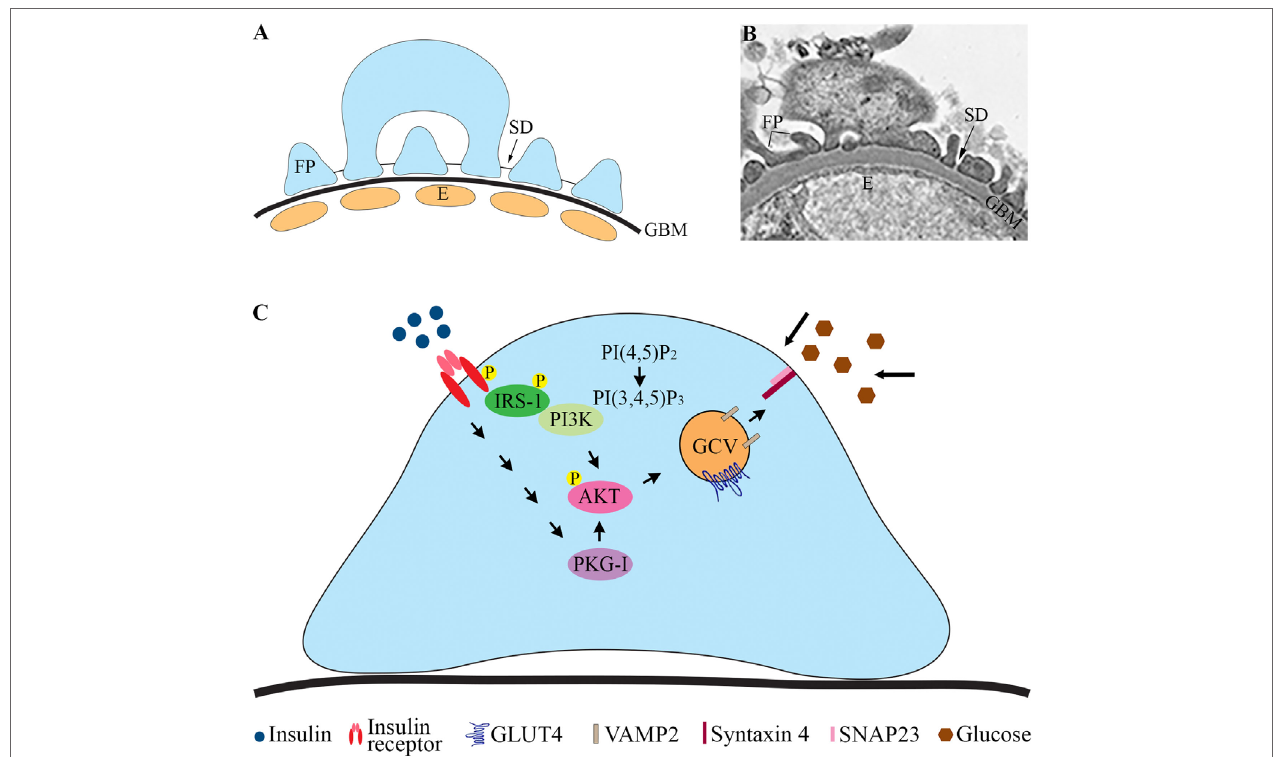
FiGURe 1 | Glomerular filtration barrier (GFB) and schematic cartoon of the insulin signaling pathway in podocytes. (A) Schematic structure of GFB. (B) Electron microscopic image of the GFB in mouse. (C) Insulin activates the insulin receptor tyrosine kinase, which recruits and phosphorylates different substrate adaptors, such as the IRS family proteins. Tyrosine-phosphorylated IRS-1 binds PI3K. The catalytic subunit of PI3K phosphorylates phosphatidylinositol (4,5)-bisphosphate (PIP2) leading to the formation of phosphatidylinositol (3,4,5)-trisphosphate (PIP3). PI3K is also linked to the activation of the protein kinase Akt (protein kinase B), and further downstream to the translocation of GCVs to the plasma membrane. Also, activation of PKG-I leads to enhanced phosphorylation of AKT and increases glucose uptake. E, endothelial cell; FP, foot process; GBM, glomerular basement membrane; GCV, GLUT4-containing vesicle; IRS-1, insulin receptor substrate-1; P, phosphorylation; PI3K, phosphoinositide 3-kinase; PKG-I, cGMP-dependent protein kinase G type I.